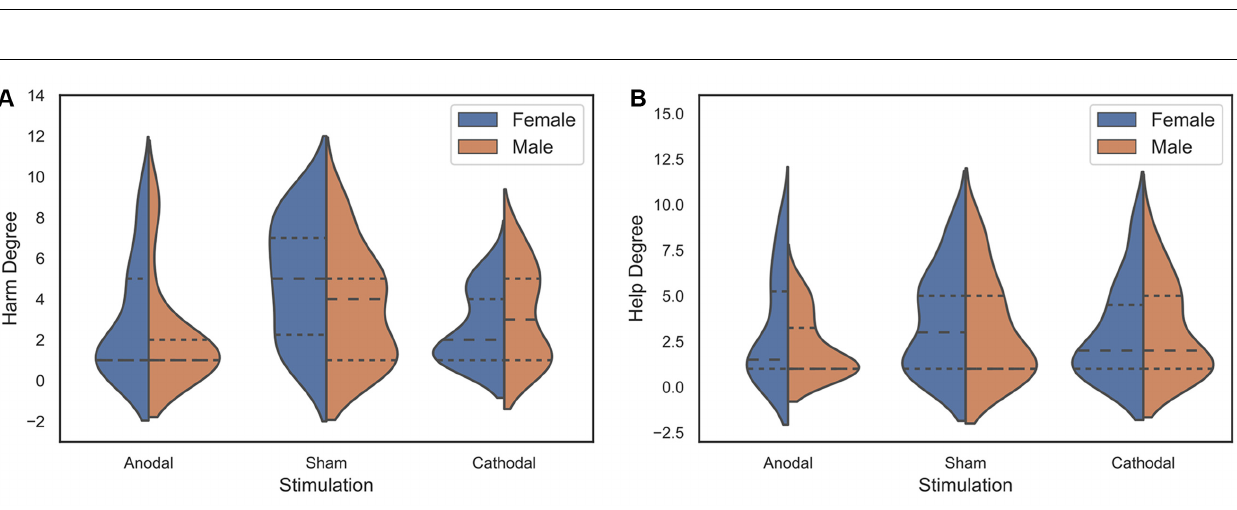
FIGURE 4 | Data of the harm degree (A) and help degree (B) for females and males under three stimulation